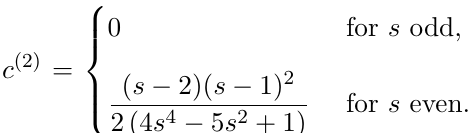
Figure 4 . Self energy correction to the